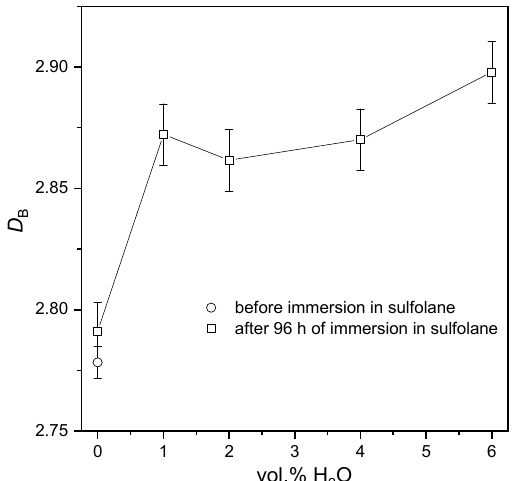
Figure 4. Fractal dimension ( D B ) in the function of the water concentration in sulfolane.